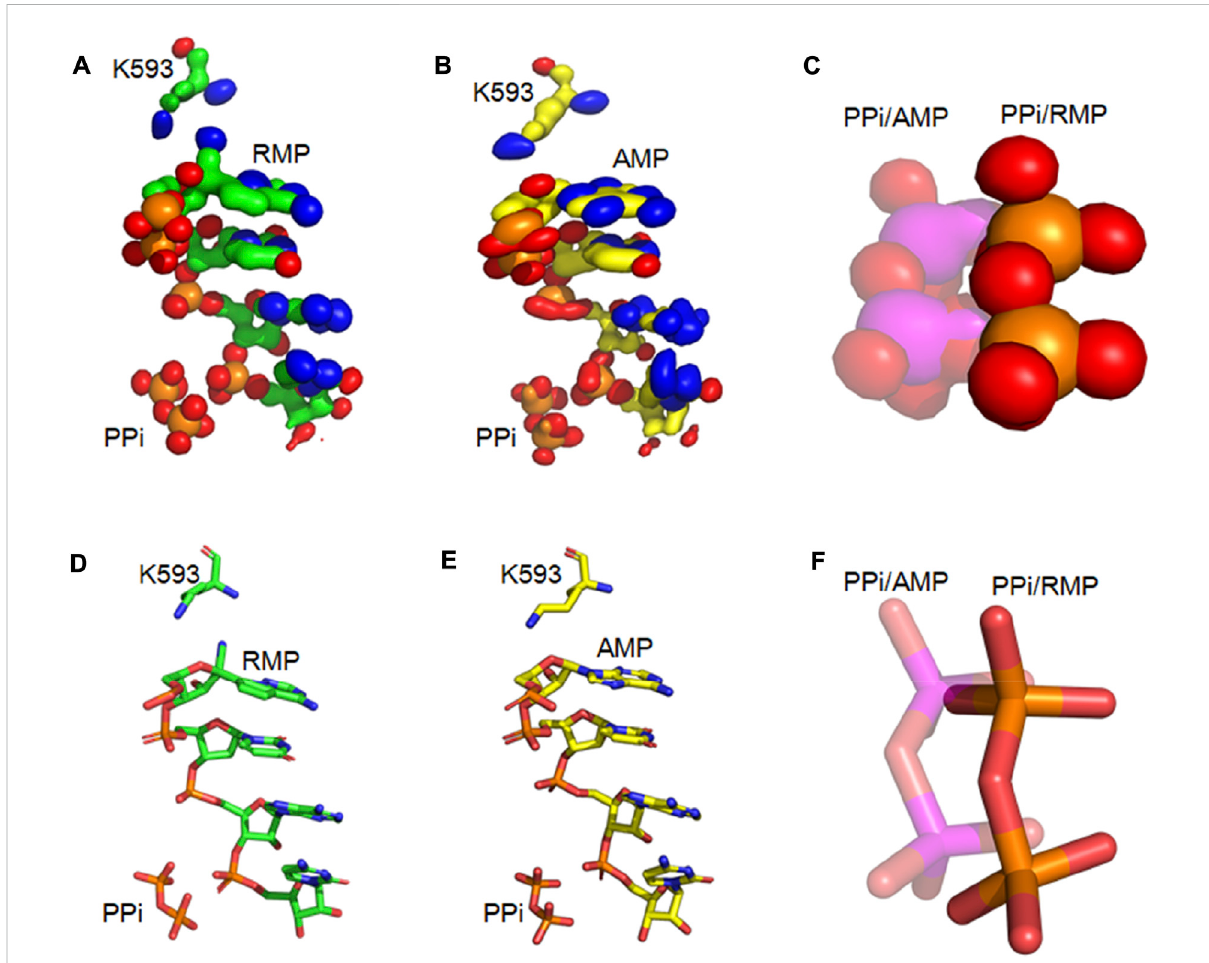
FIGURE 4 Iso-PDFDistributionofPPiandprimerRNAstrands (A,B) Iso-PDFforbasesfromthe fi rstthreeprimernucleotides,K593,andPPiforRMP (A) and AMP (B) at position i + 3. (C) Close-up view of iso-PDF for PPi (RMP structure: solid; and AMP structure: transparent). (D) The i + 3 RMP complex structure for showingK593,PPi, and 4nucleotidesoftheprimerstrand. (E) Corresponding i + 3AMPcomplexstructure. (F) Superposition ofthetwo